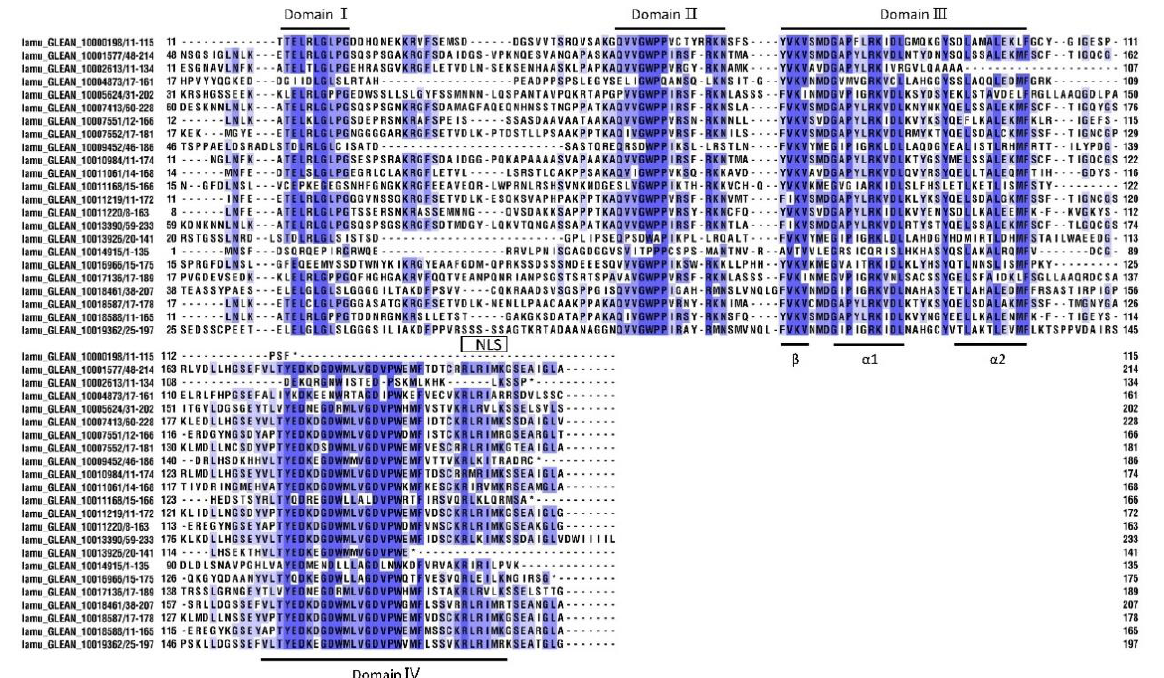
Figure 2. Multiple sequence alignment of conserved domains in MoIAAs’ proteins.